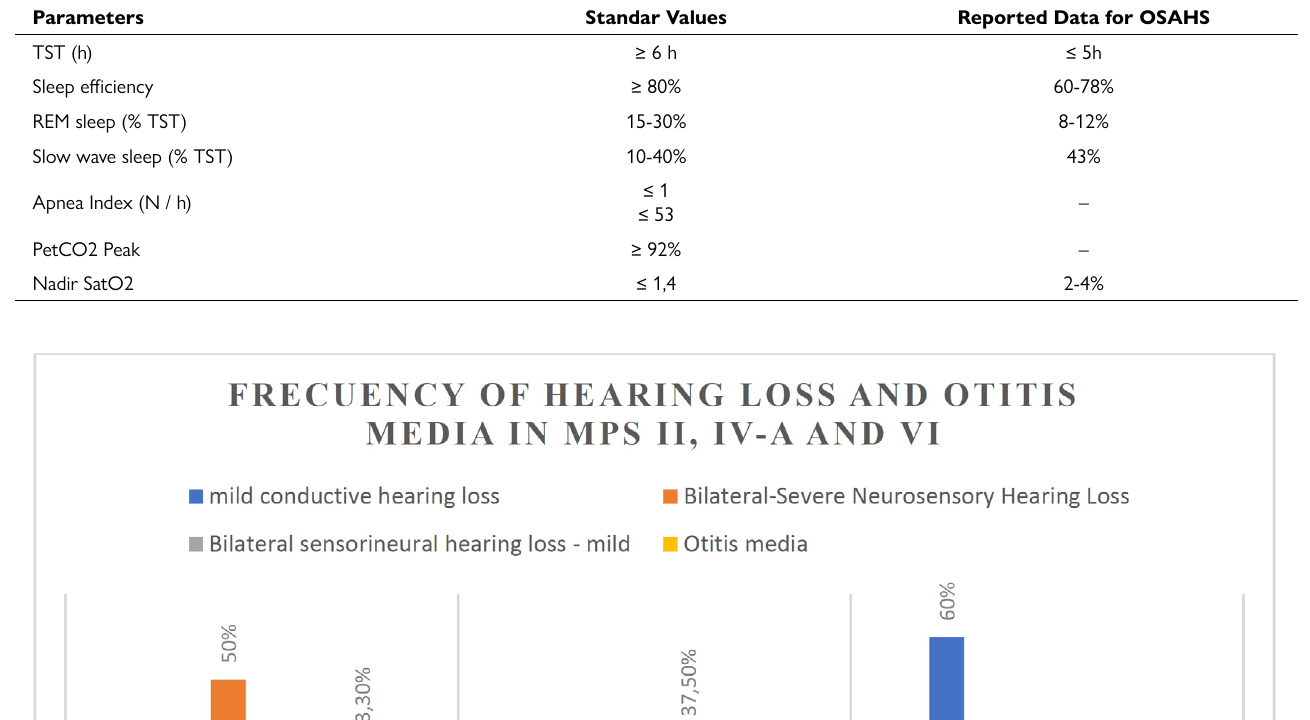
Table 1. reference values for polysomnography study and reported data.